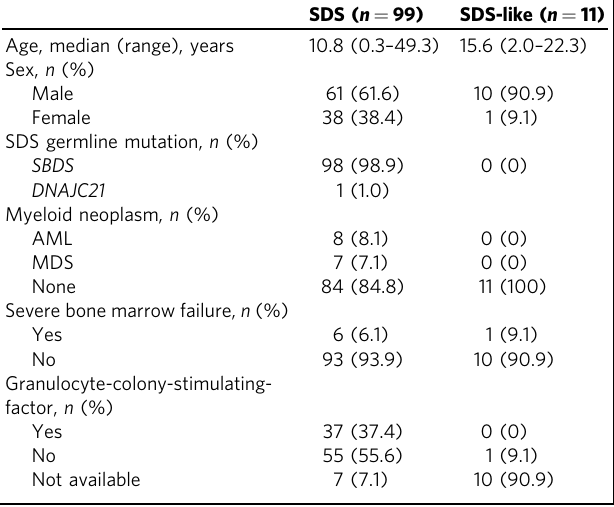
Table 1 Patient